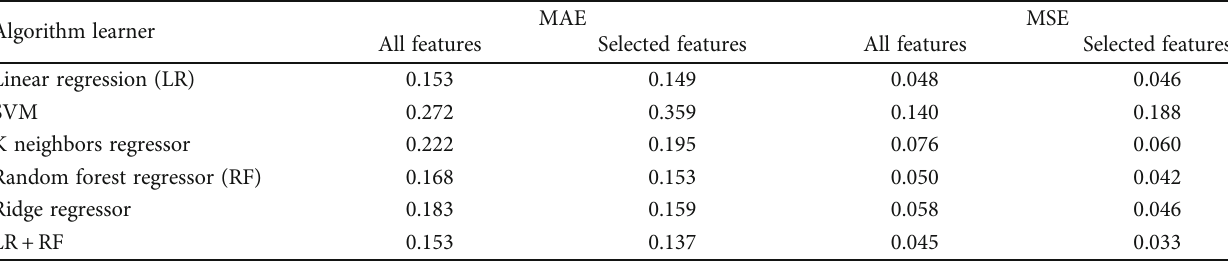
Table 2: Accuracy of visual acuity predictions.